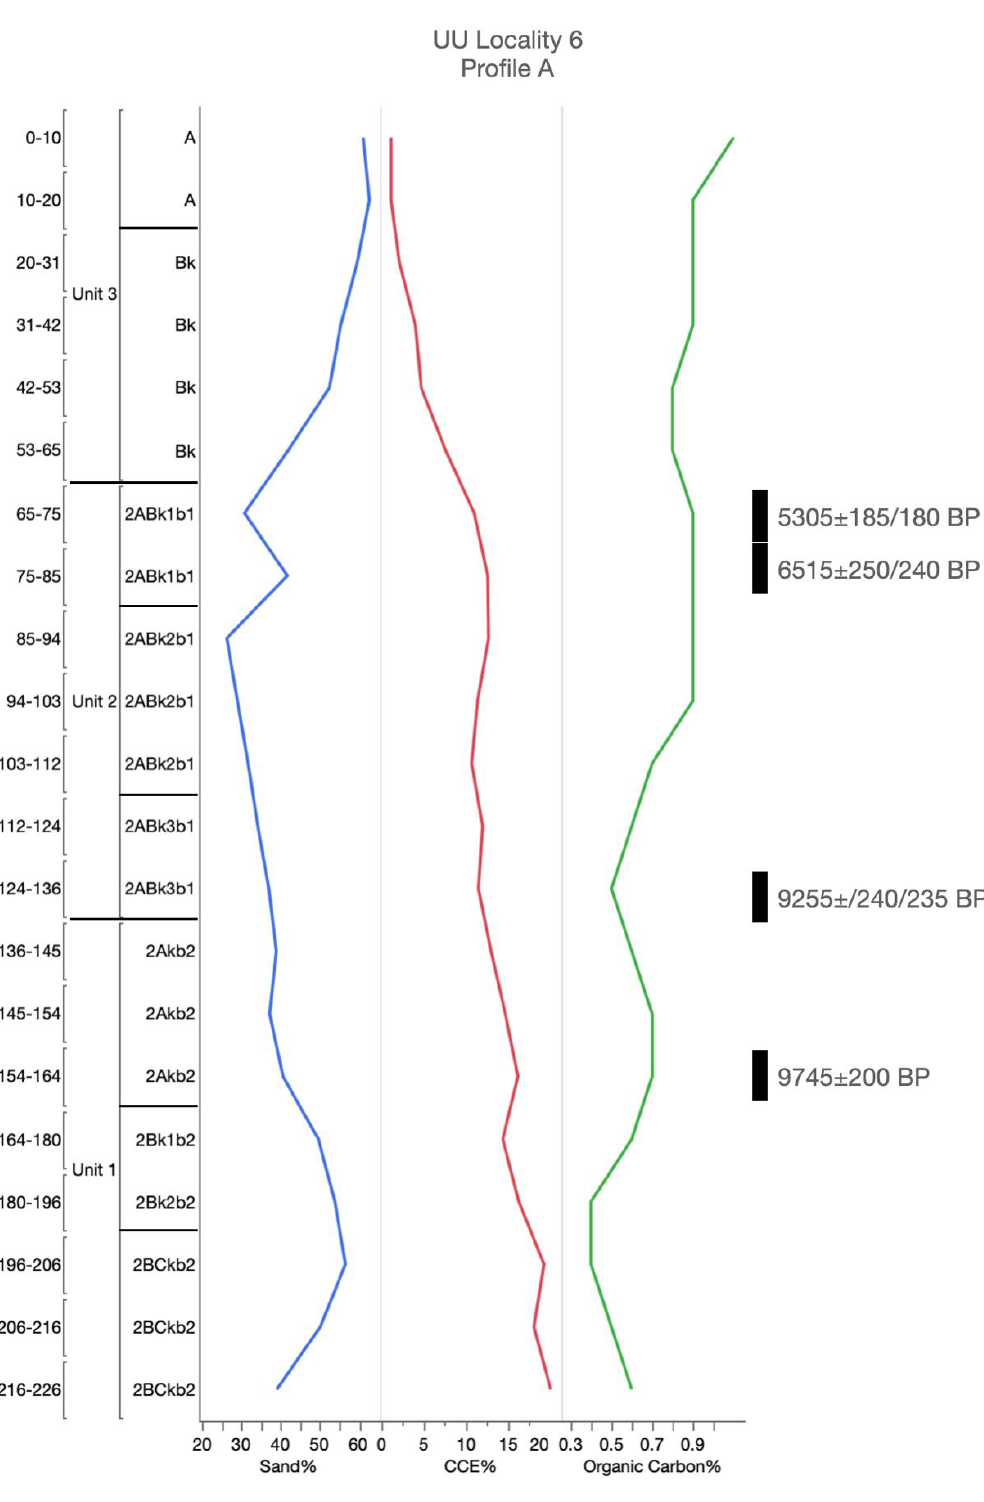
Figure A3. Accepted radiocarbon ages and soil and sediment analysis at UU Locality 6, Profile A—Post research area, northwest, Texas. CCE = calcium carbonate equivalence.